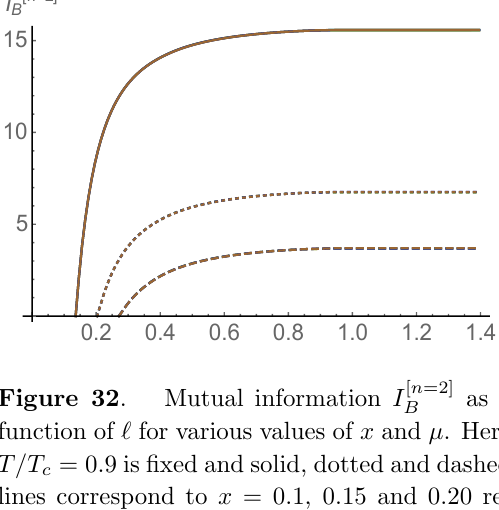
Figure 31 . Mutual information I [ n =2] function of ‘ for various values of x and T . Here (cid:22) = 0 is (cid:12)xed and solid, dotted and dashed lines correspond to x = 0 : 1, 0 : 15 and 0 : 20 respec- tively. The Red, green, blue and black curves correspond to T=T c = 0 : 9, 0 : 8, 0 : 7 and 0 respec- tively. In units GeV.